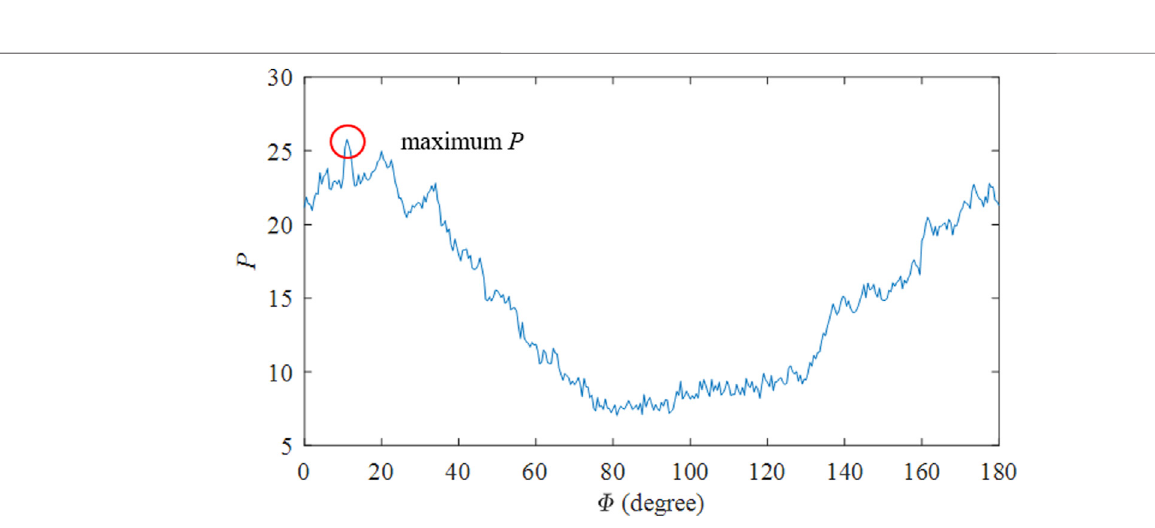
Frontiers in Earth Science |